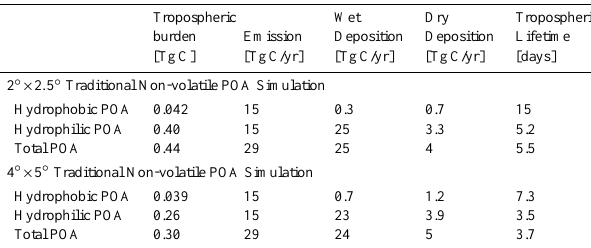
Table A2. Traditional (non-volatile POA) simulation for 2 ◦ × 2 . 5 ◦ and 4 ◦ × 5 ◦ grid resolution. 2 ◦ × 2 . 5 ◦ simulations are performed with GEOS-4 assimilated meteorology. 4 ◦ × 5 ◦ simulations were performed with GISS GCM Model 3 meteorology.